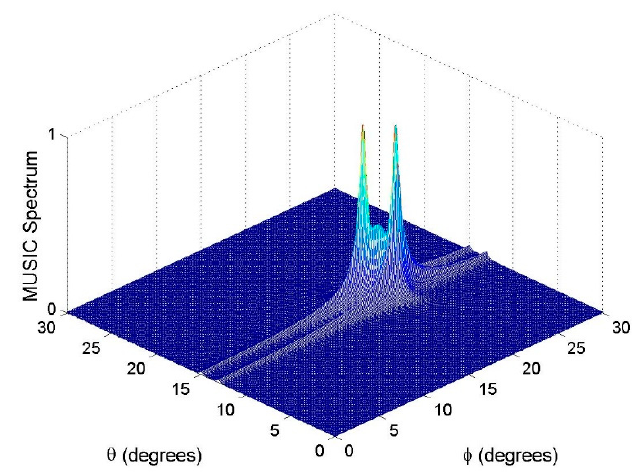
Figure 4. MUSIC spectrum of the benchmark.